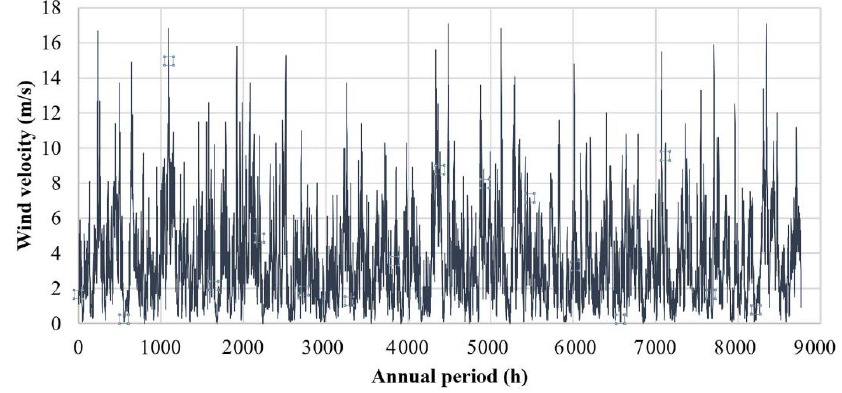
Figure 4. The annual wind velocity time series as measured by the meteorological station of the HNMS.